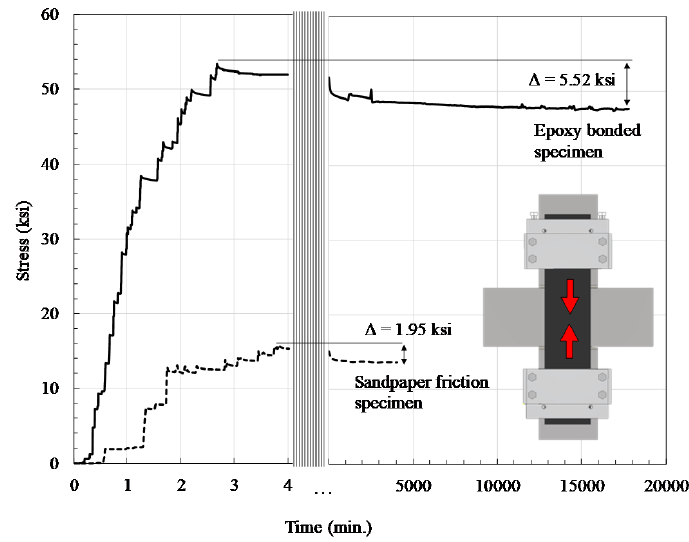
Figure 20. Measured CFRP pre-stress losses due to relaxation and creep.